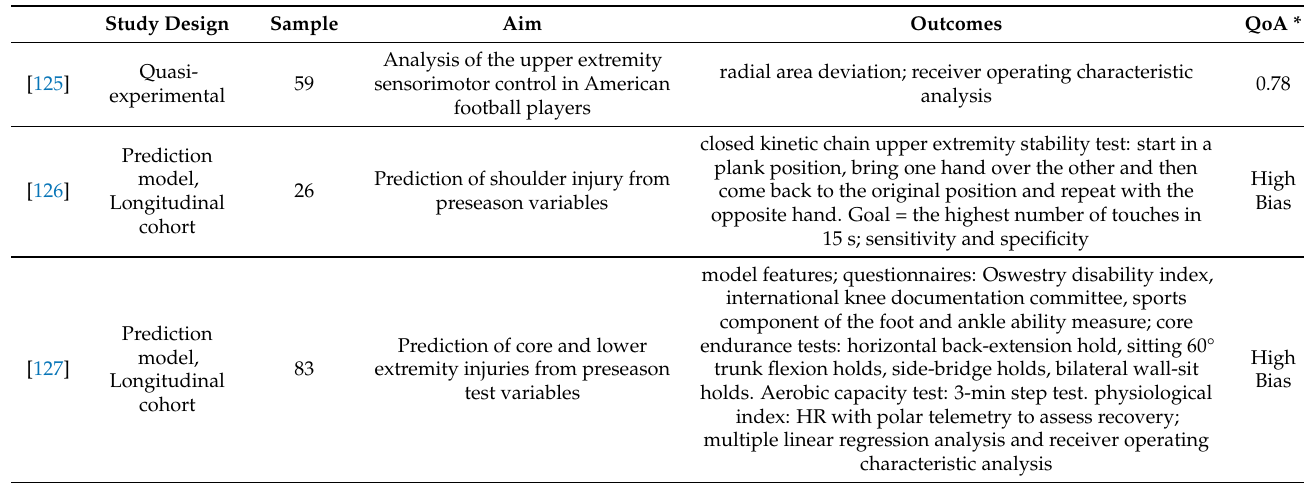
Table 9. Studies regarding